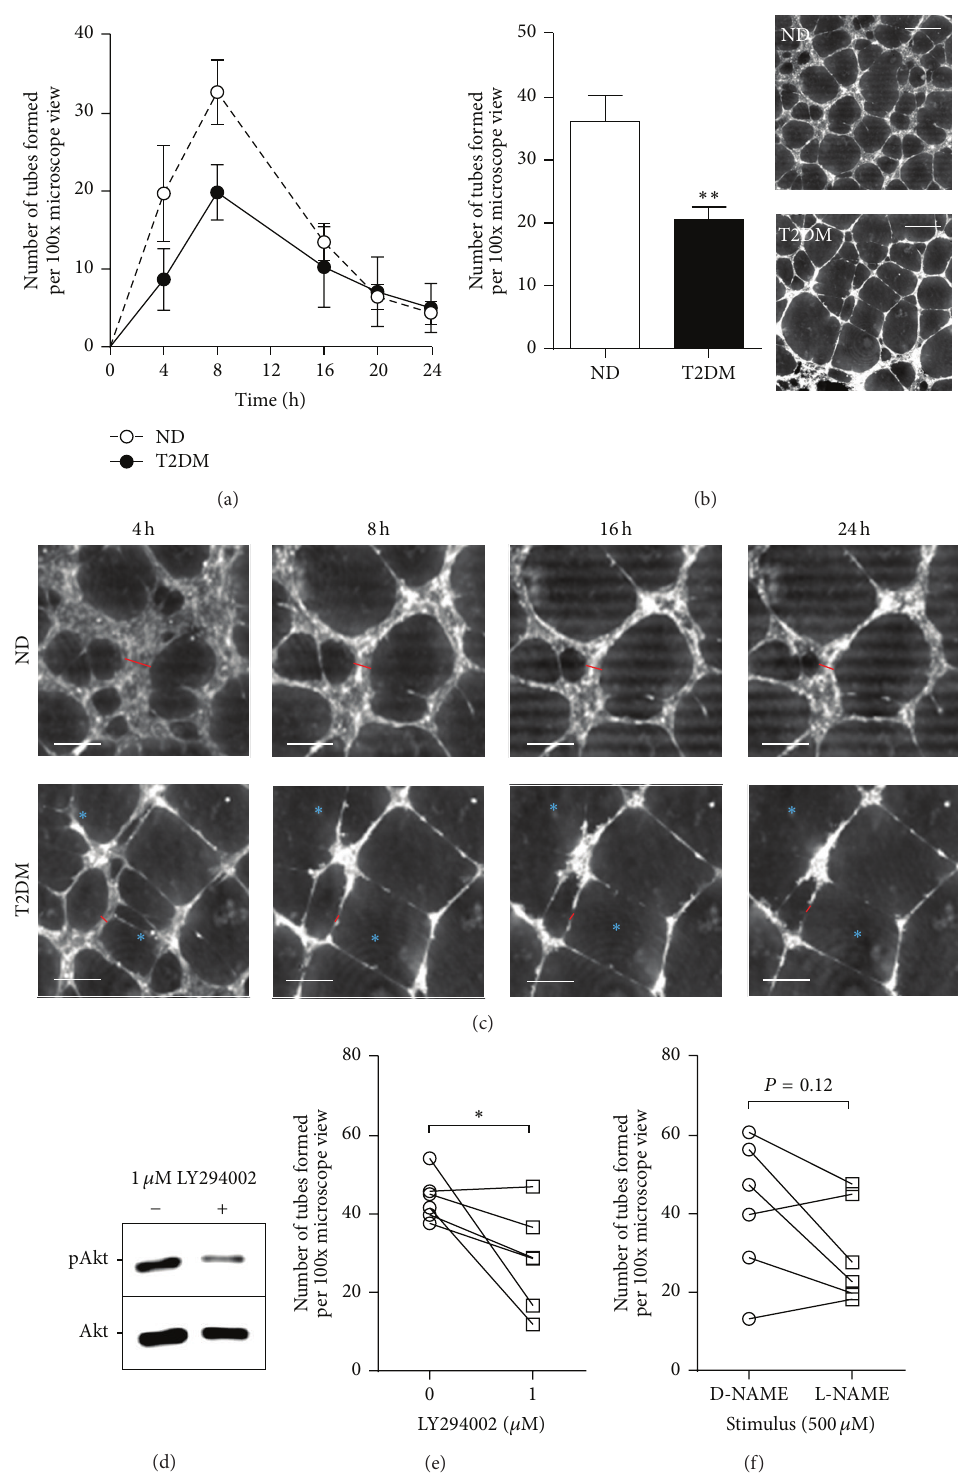
Figure4:SV-ECangiogenesis.AngiogenesisassayswereperformedbyseedingEContoMatrigelandquantifyingthenumberoftubesformed over time. (a) The number of intact tubes in 10 fields per population ( × 100 magnification) were quantified over 4–24 h by two independent observers ( 𝑛 = 4 ). (b) Number of intact tubes formed after 8h ( 𝑛 = 7 , ∗∗ 𝑃 < 0.01 ) with representative images using the Phase Focus Virtual Lens(PFVL21).Scalebar=500 𝜇 m.(c)Enlargedimagesshowingthesamefieldoverextendedtimecourse. Thewidthoftubewallsisindicated by a red bar, and breakage of walls is indicated by blue asterisks (scale bar = 250 𝜇 m). (d) Cells were exposed to 1 𝜇 M LY294002 for 24h and lysates were immunoblotted for phosphorylation of Akt. (e) ND-EC were treated with 1 𝜇 M LY294002 for 24 h prior to incorporation